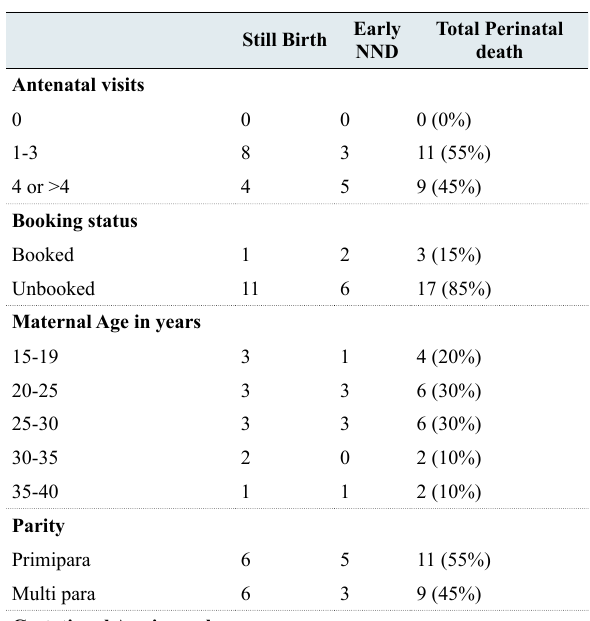
Table 2 Characteristics of women with perinatal deaths in the